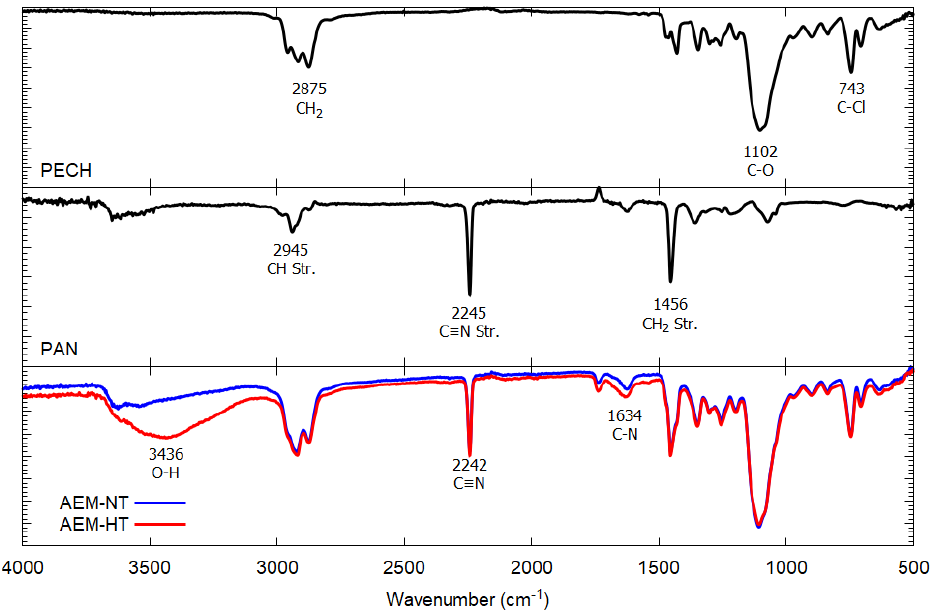
Figure 3. PECH, PAN, AEM-NT and AEM-HT FTIR spectrums.